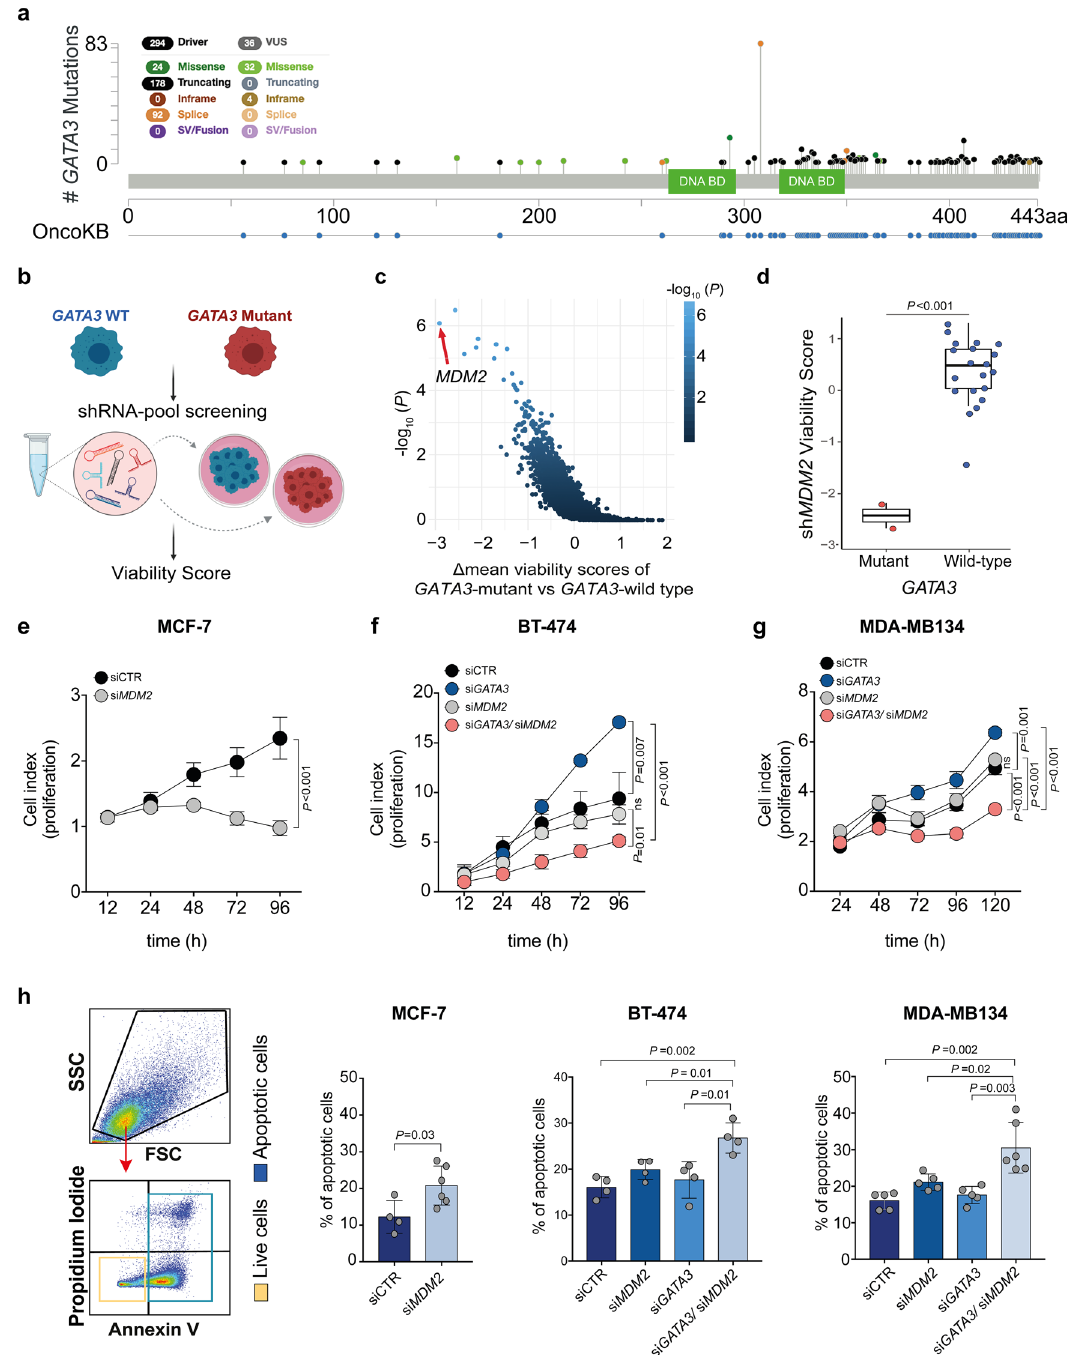
Fig. 1 GATA3 and MDM2 are synthetic lethal in ER-positive breast cancer. a Lollipop plot depicting GATA3 somatic mutations and OncoKB 96 annotation in ER + breast cancer derived from the TCGA PanCancer Atlas 1 and the METABRIC datasets 4 . b Schematic representation of the project DRIVE shRNA screen data used to identify synthetic lethal interactors of GATA3 . c SLIdR-derived statistical signi fi cance (-log 10 ( P )) plotted against the difference in the mean viability scores between GATA3 -mutant and GATA3 -wild type breast cancer cell lines for each gene knocked down in the shRNA screen. The middle lines of the boxplots indicate medians. Box limits are fi rst and third quartiles. The whiskers extend to the range. d Viability scores of MDM2 knock-down in GATA3 -mutant and GATA3 -wild type cell lines. e – g Proliferation kinetics of e GATA3 -mutant MCF-7 transfected with siRNA targeting MDM2 or control (see also Supplementary Fig. 1a – c), f GATA3 -wild type BT-474, g GATA3 -wild type MDA-MB134 transfected with siRNA targeting GATA3, MDM2, GATA3/ MDM2 , or control (see also Supplementary Fig. 1d, e). h Apoptosis assay using Annexin V and propidium iodide co-staining. From left: gating strategy to de fi ne apoptotic (blue) and live (yellow) cells; percentage of apoptotic and live cells upon MDM2 silencing in MCF-7 (see also Supplementary Fig. 1f) upon silencing of GATA3 and MDM2 alone or in combination in BT-474 and MDA-MB134. Data are mean ± s.d. n ≥ 3 biologically independent replicates. Statistical signi fi cance was determined for e – g by multiple t test and for h by two-tailed unpaired Student ’ s t test. b was created with BioRender.com.